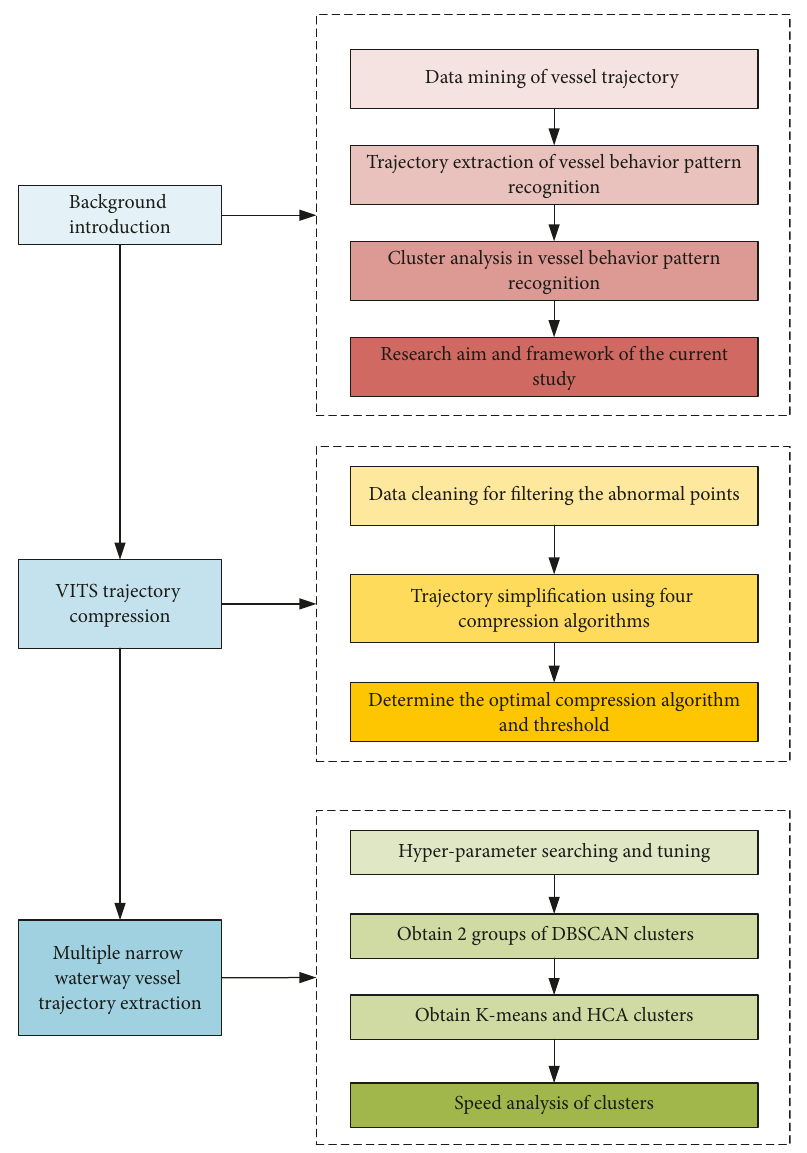
Figure 1: Research framework of the current